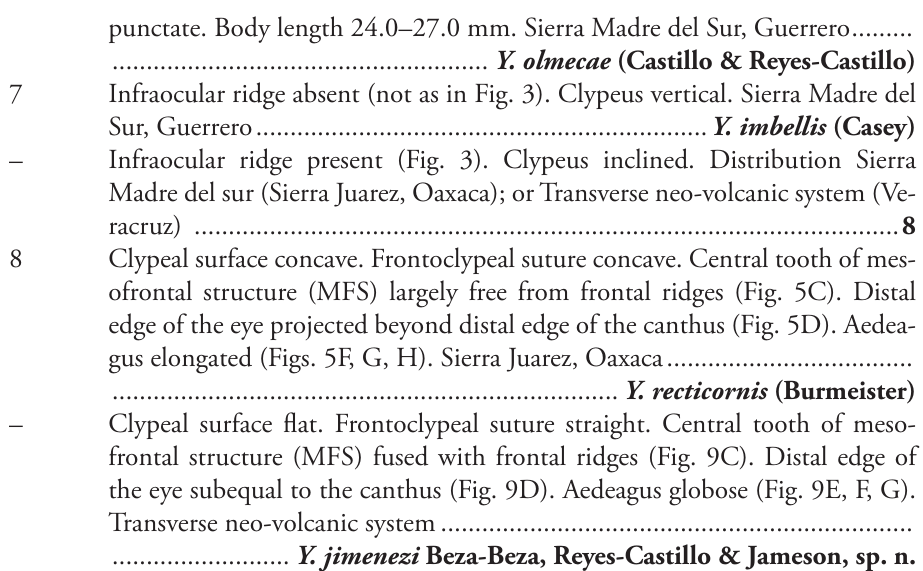
Infraocular ridge absent (not as in Fig. 3). Clypeus vertical. Sierra Madre